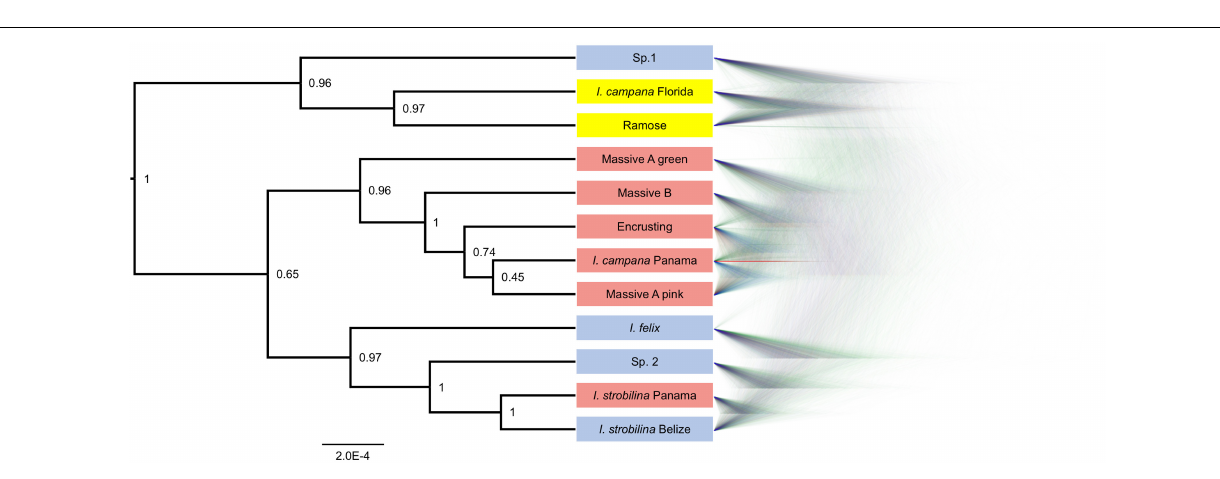
sites relative to across sites ( Figure 5 ). In both plots, SNPs from both populations of I. strobilina were predominantly sourced from a shared ancestral population, whereas I. campana was split between two ancestral populations that coincided with geography.